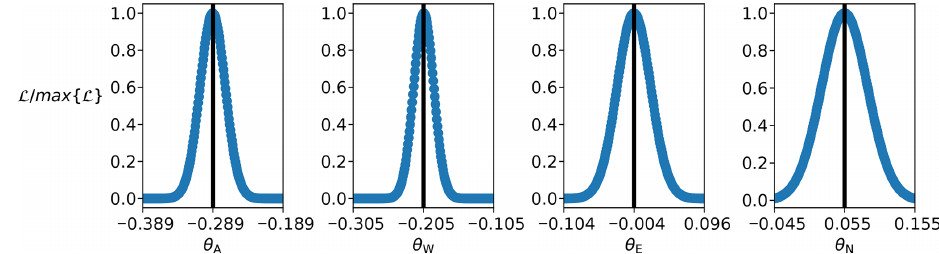
Figure 1. Presented are the pointwise parameter likelihoods (when setting the other parameters at their optimal values), divided by the maximum likelihood value. The vertical lines indicate the parameter value with the highest likelihood.